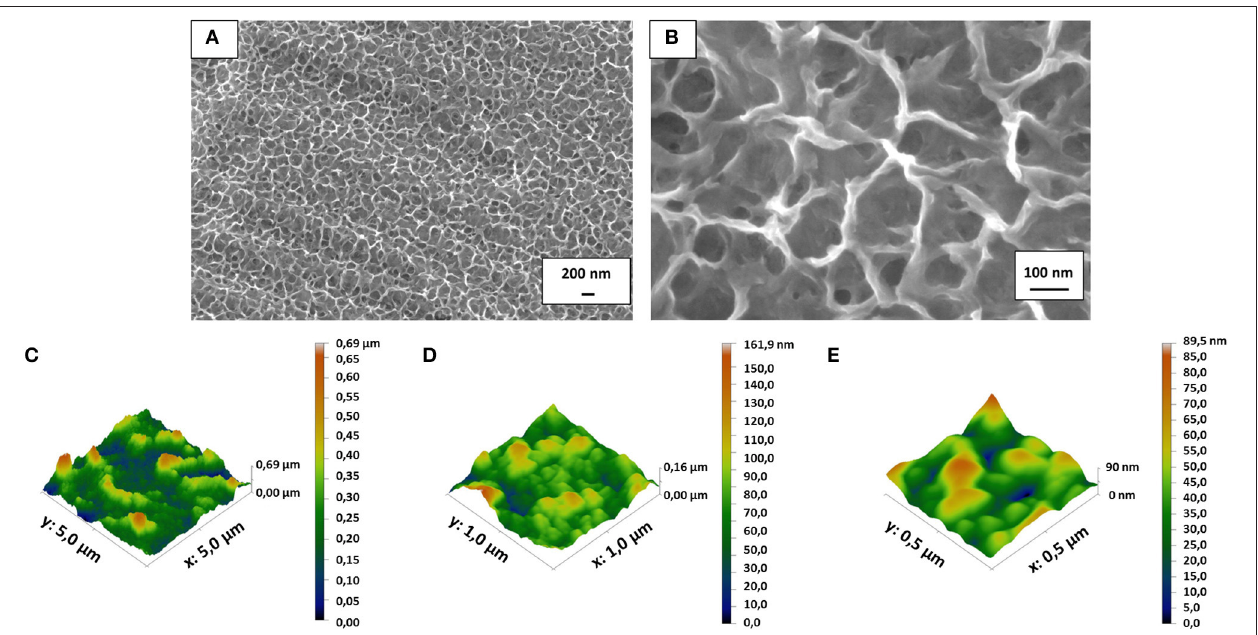
FIGURE 1 | FESEM images revealed the presence of the nanotextured oxide layer obtained after the chemical treatment on the mirror polished flat Ti6Al4V discs (A,B) . Surface roughness obtained by AFM measurements (C–E) confirmed that the surface texture is in the nanoscale (10–100nm depending on the measurement area due to the complex roughness at the nano- and micro-scale of the surface).